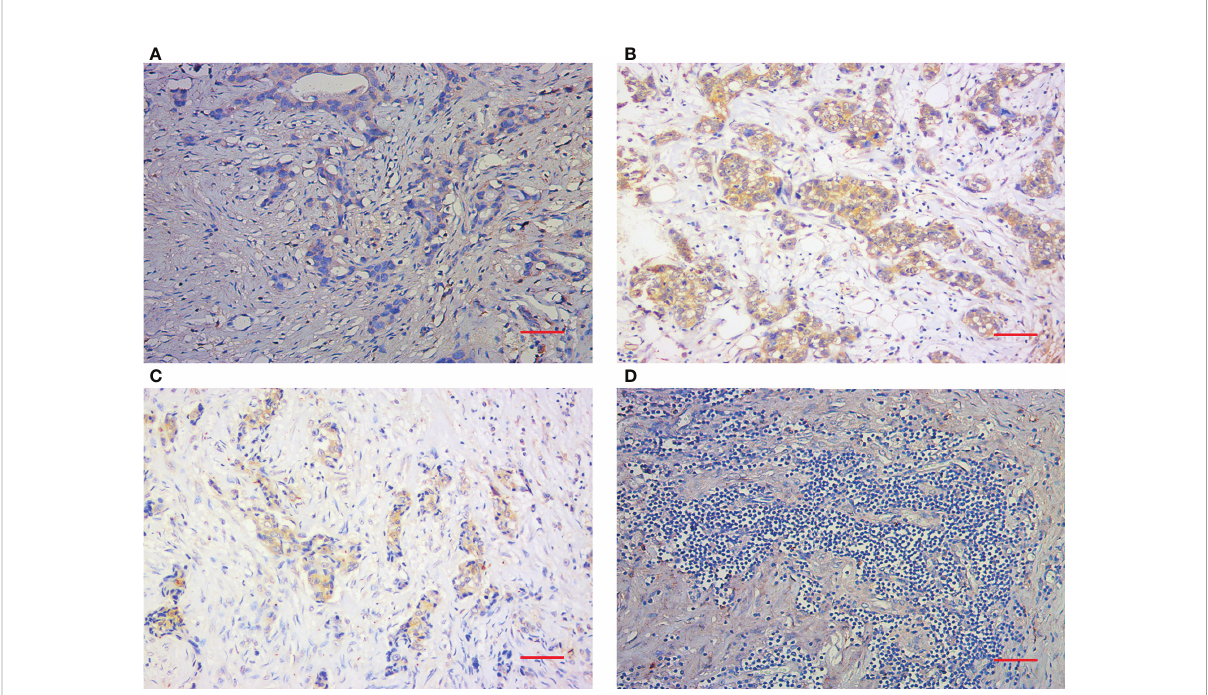
FIGURE 1 Immunohistochemical staining of TILs and CXCR4. (A) Representative IHC images of negative CXCR4 staining (200X). (B) Representative IHC images of positive CXCR4 staining. (C) Representative IHC images of low TIL staining. (D) Representative IHC images of high TIL staining (200X). Scale bar (Red): 50 m